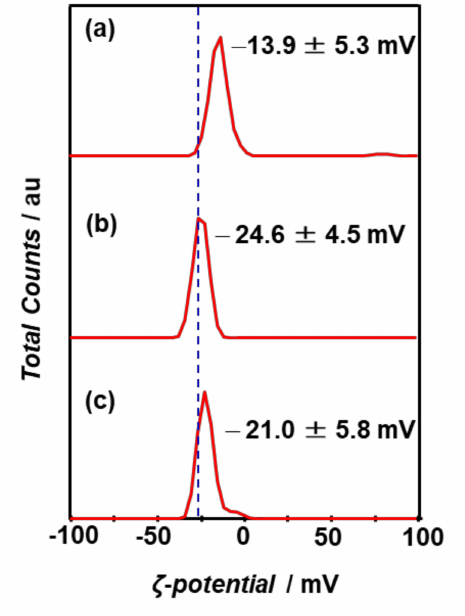
Figure 9. ζ -Potentials of ( a ) the assembly of 25 µ M Ni-NTA modified β -annulus peptide, (b ) 25 µ M His-tagged HRP, and ( c ) their 1:1 mixture in 10 mM Tris-HCl bu ff er (pH